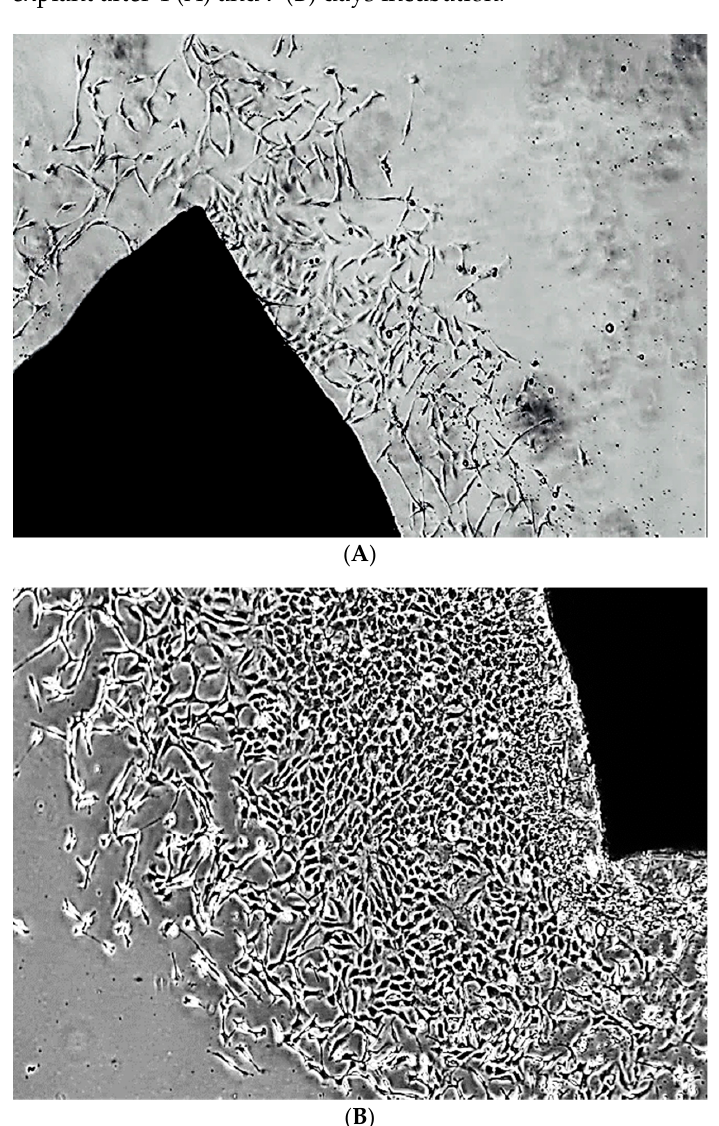
Figure A1. In vitro culture of rat aortic VSMCs from aortic explants viewed at 160 X magnification (10 X E-PL, 4 X objective lens, 40 × image magnification) under an inverted Olympus light microscope. ( A ) Cell growth after 4 days incubation; ( B ) cell growth after 7 days incubation (scale bar: 27.2851 µ m). Figure A2 is a visual presentation of the stained rat aortic VSMCs depicting the presence of SM22 α actin